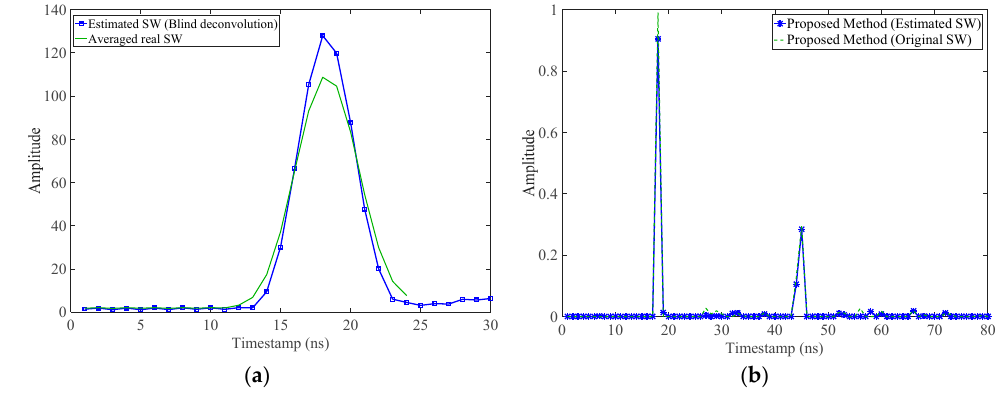
Figure 9. ( a ) The reconstructed system waveform by blind deconvolution versus the average of the recorded system waveforms; and ( b ) comparison of the restored signals based upon the original incomplete system waveform and that retrieved from blind deconvolution.